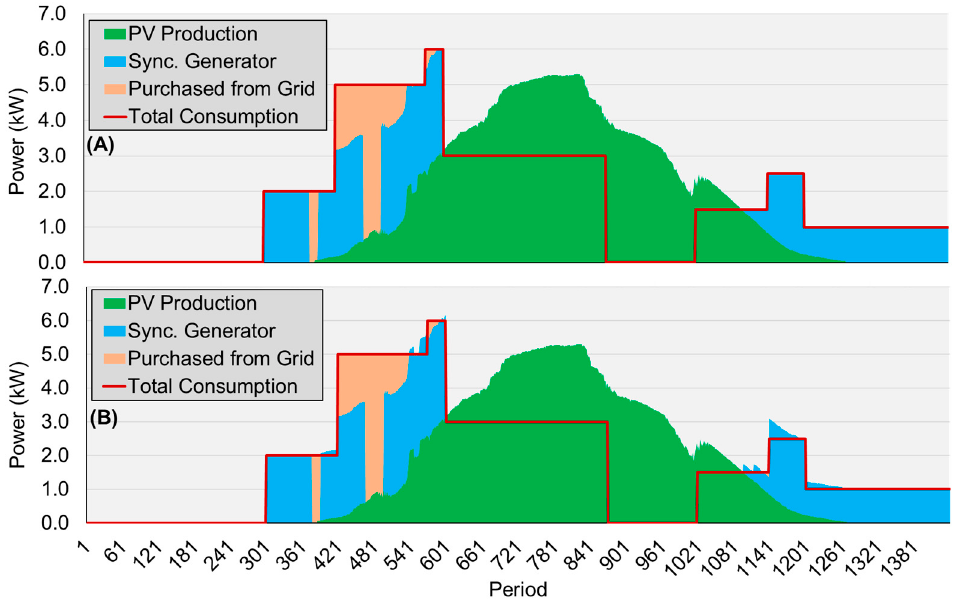
Figure 10. Energy scheduling results using ( A ) an optimization algorithm; ( B ) DT.